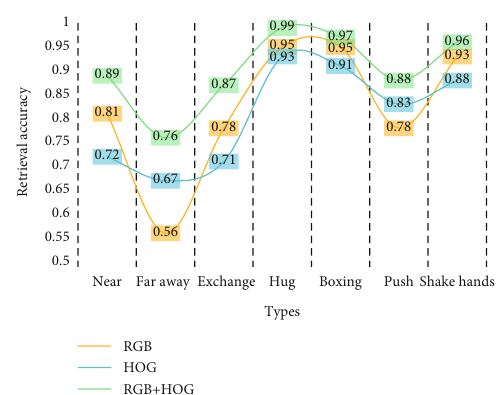
Figure 6: Comparison of single-feature and multifeature retrieval.